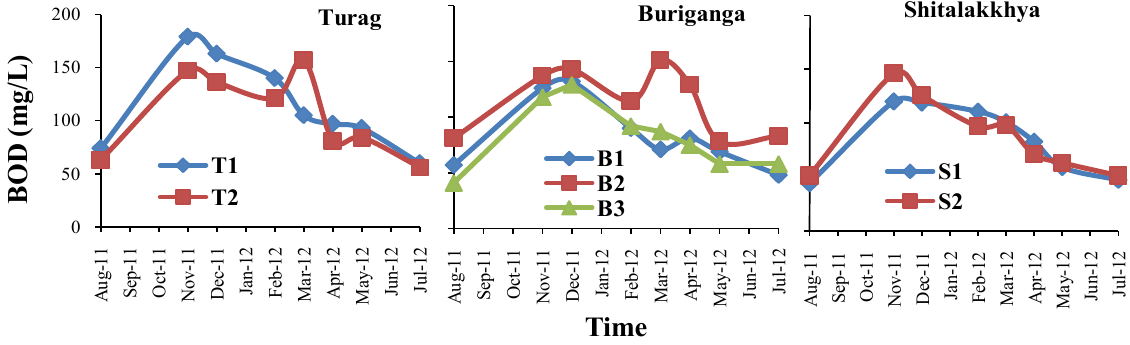
Figure 8. The biochemical oxygen demand (BOD) values of the samples from the water of three different rivers around Dhaka